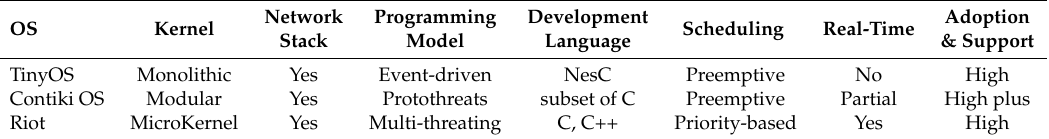
Table 5. Comparison summary of operating systems for Hidra test-bed implementation.